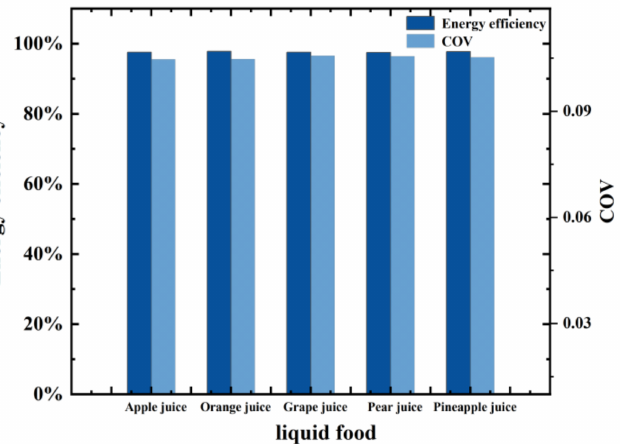
Figure 13. S11 and COV values of the continuous-flow sterilization system for different types of liquid